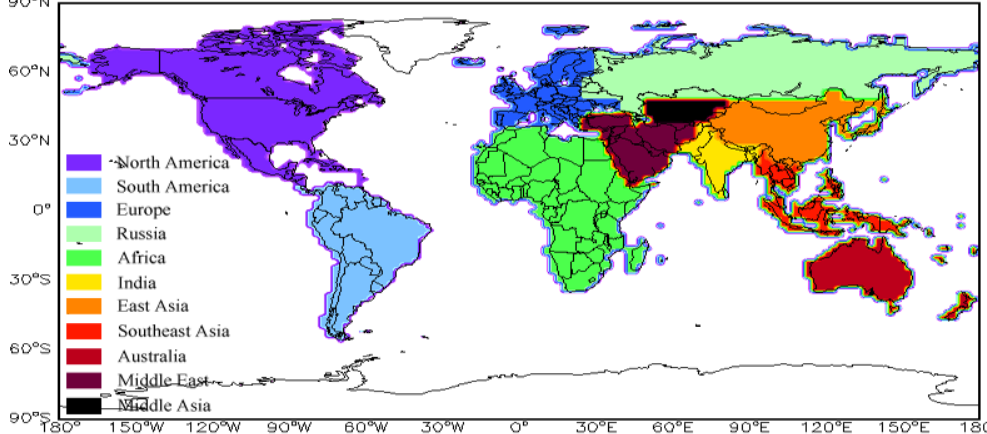
Figure 1. The 11 continental regions tagged in our GEOS-Chem simulations.